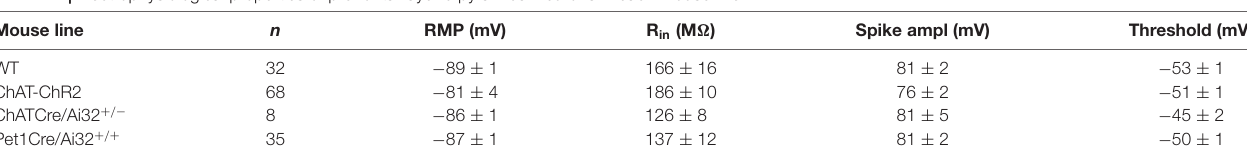
TABLE 1 | Electrophysiological properties of prefrontal layer 6 pyramidal neurons in each mouse line. Mouse